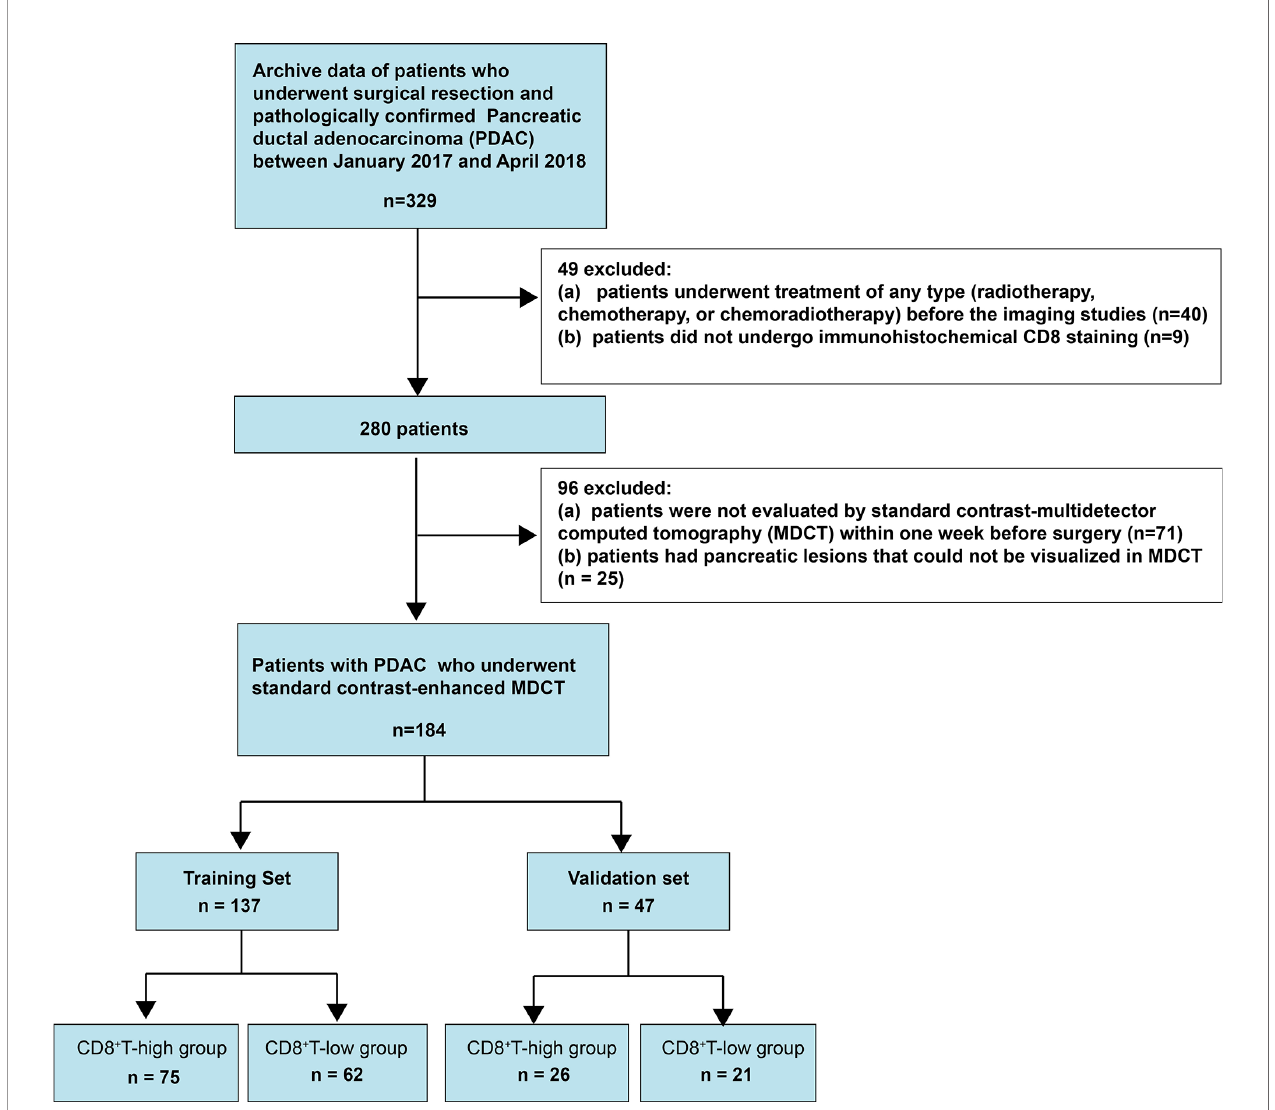
FIGURE 1 | Flow chart visualizing the patient selection